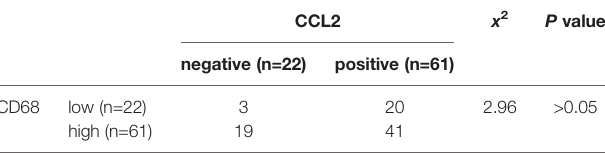
TABLE 4 | Correlation analysis of CCL2 and CD68 expression in cohort (n=83) colorectal cancer (CRC) tissues.